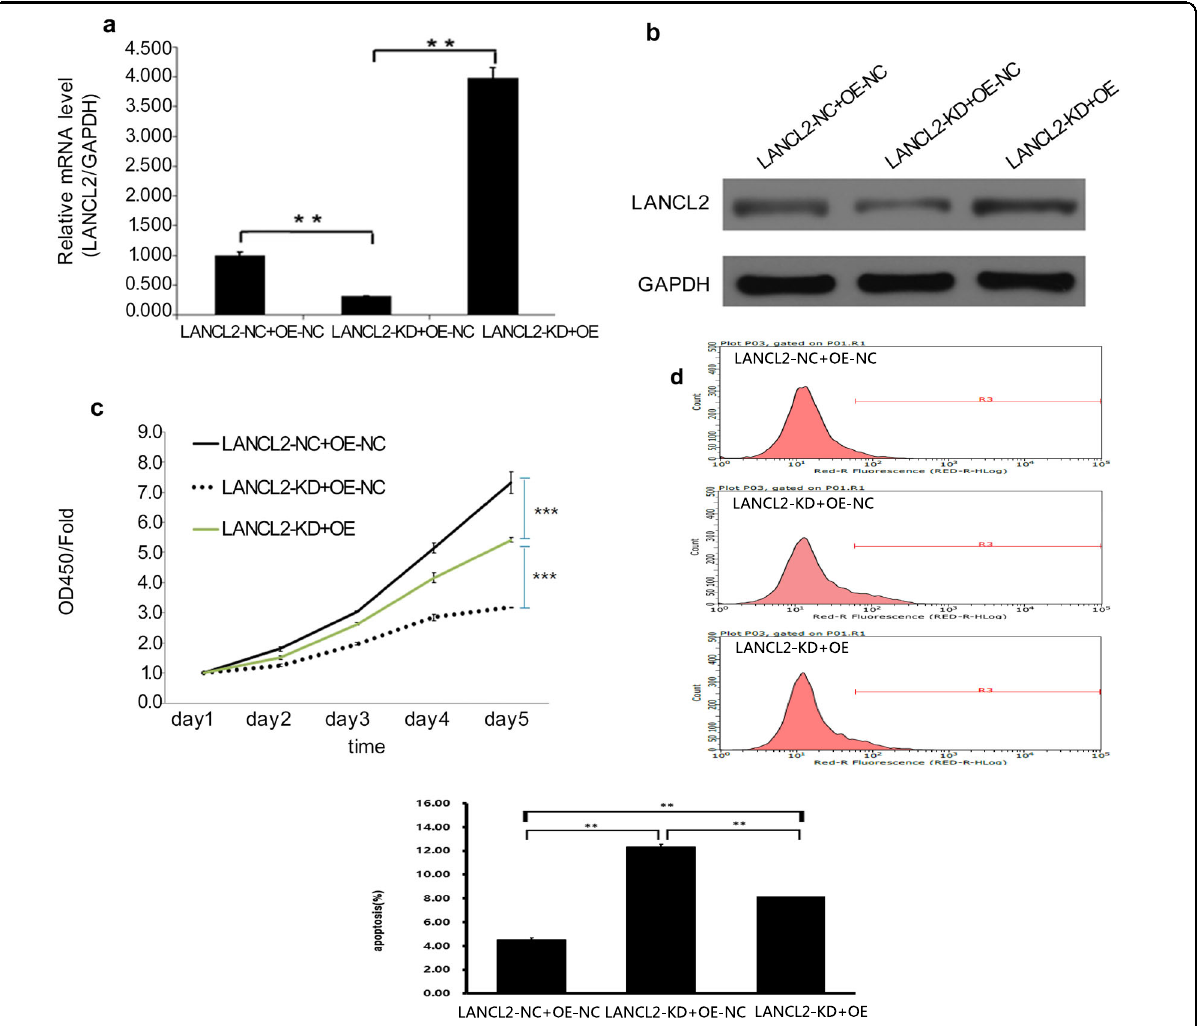
Fig. 4 LANCL2 overexpression rescues effects of LANCL2 knockdown in PC9 cells. a mRNA and b protein expression levels of LANCL2 in negative control (LANCL2-NC + OE-NC), LANCL2 knockdown (LANCL2-KD + OE-NC), and LANCL2 knockdown with LANCL2 rescue overexpression (LANCL2-KD + OE) PC9 cells. c CCK-8 cell proliferation assay and d fl ow cytometry analyses of apoptosis using Annexin V staining in infected